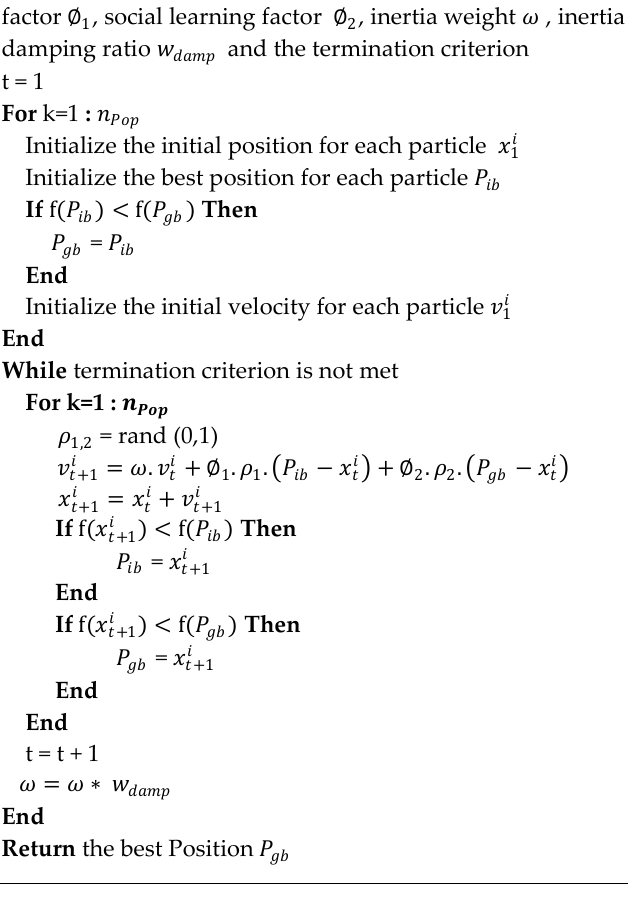
Figure 7. Pseudocode of the used particle swarm optimization algorithm.